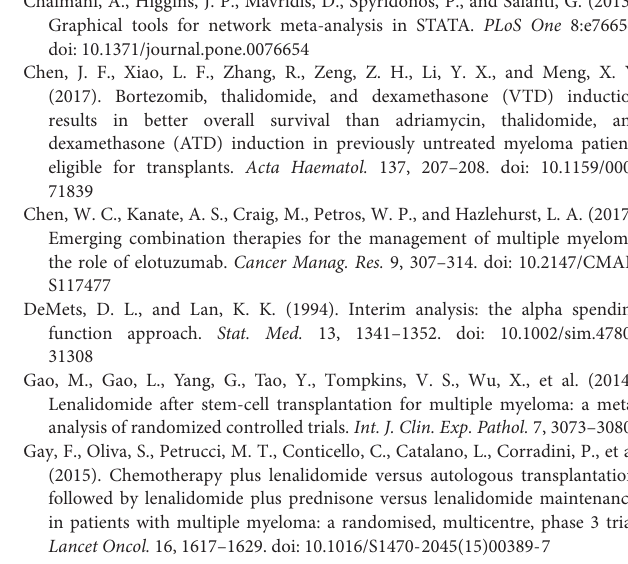
FIGURE S3 | Trial sequential analysis (TSA) results. The left column for PFS and right for OS. Each row from top to bottom corresponds to the overall analysis, and analyses for the subgroup of ASCT trials, subgroup of no ASCT trials, subgroup of thalidomide-based therapies and subgroup of lenalidomide-based therapies, respectively. FIGURE S4 | Network map of included maintenance strategies for PFS (A) and OS (B) . The size of node is weighted by the number of direct comparisons, and the size of edge weighted by the precision which is measured by reciprocal of the sampling variance. FIGURE S5 | Surface under the cumulative ranking curve (SUCRA) plots of NMA for PFS (A) and OS (B) . FIGURE S6 | Ranks accounting for both OS and PFS, based-on clustered ranking (A) and averaged mean rank (B) . FIGURE S7 | The summary of the ongoing RCTs and predicted network map of the updated NMA when their final results become available. FIGURE S8 | Ordinary and weighted (by sample size) least-square linear regression for the relationship between PFS and OS in MM maintenance trials. Logarithmic HRs of OS and PFS reported in 21 included studies with 24 independent datasets were investigated. Though ordinary regression revealed significant positive correlation between PFS and OS ( β = 0.9637, P = 0.0123), weighted regression with more precision indicated non-significant association ( β = 0.6150, P =